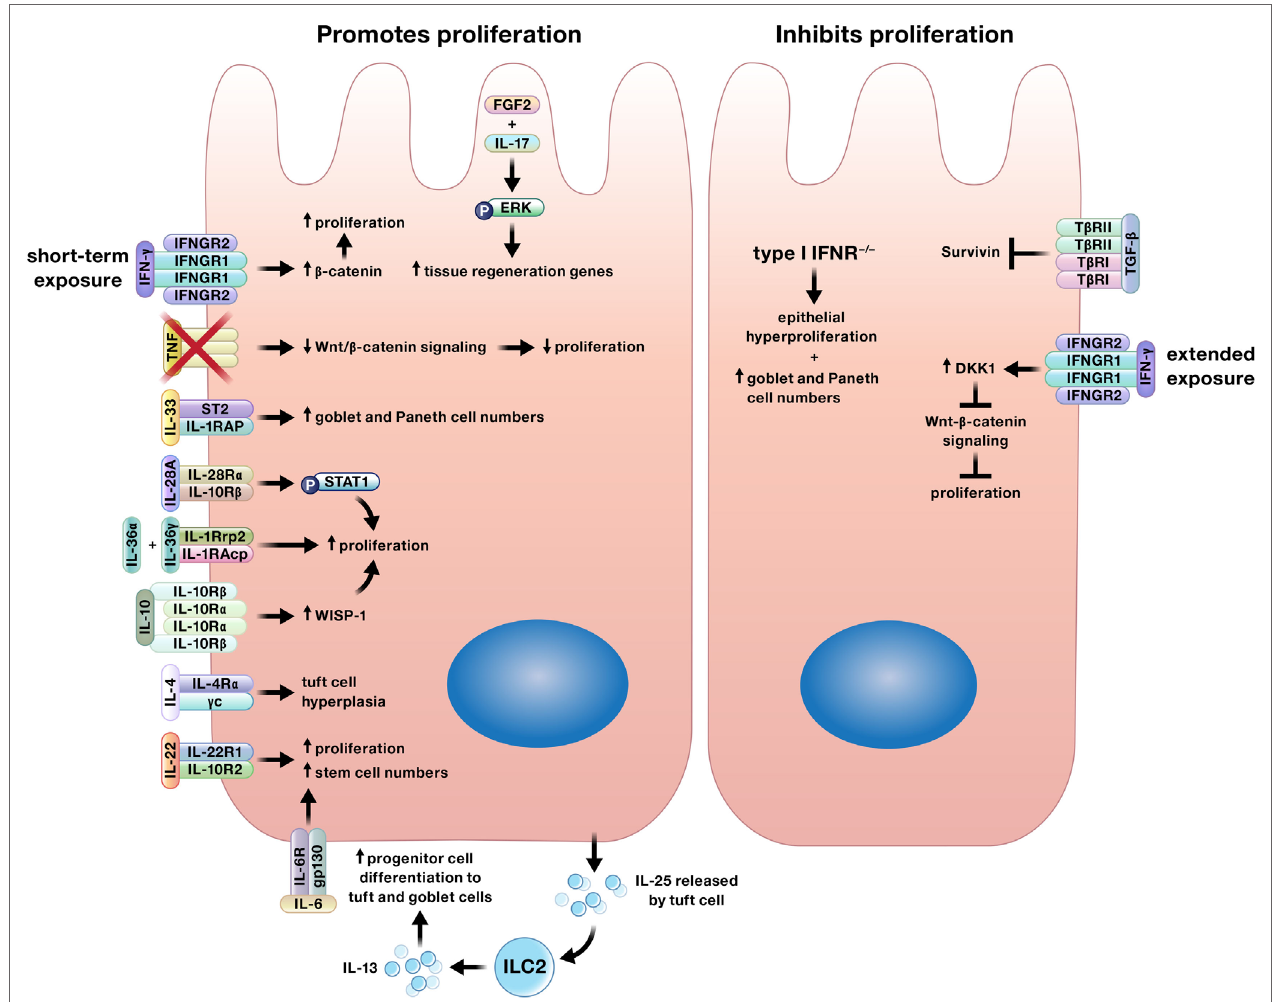
FiGURe 2 | Cytokines may promote or inhibit proliferation of intestinal epithelial cells. Interferon (IFN)- γ may induce or limit intestinal epithelial proliferation based on duration of exposure. In addition, specific cytokines may only induce proliferation of certain epithelial subtypes. For example, interleukin (IL)-4 increases tuft cell numbers, IL-13 signaling supports increases in tuft and goblet cells, and IL-33 stimulates the expansion of goblet and Paneth